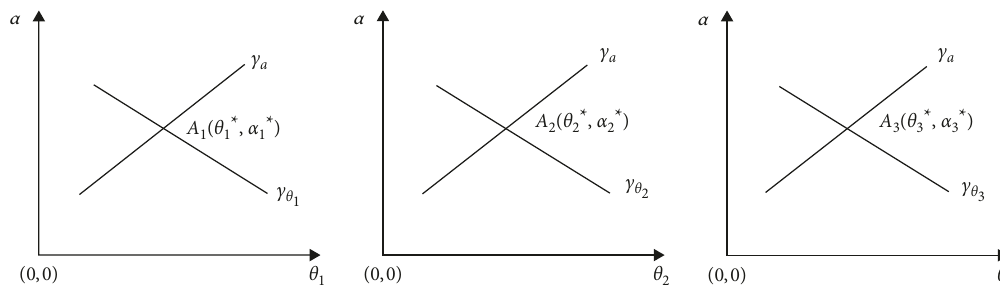
Figure 1: Behavioral interaction between local government and pollution discharging